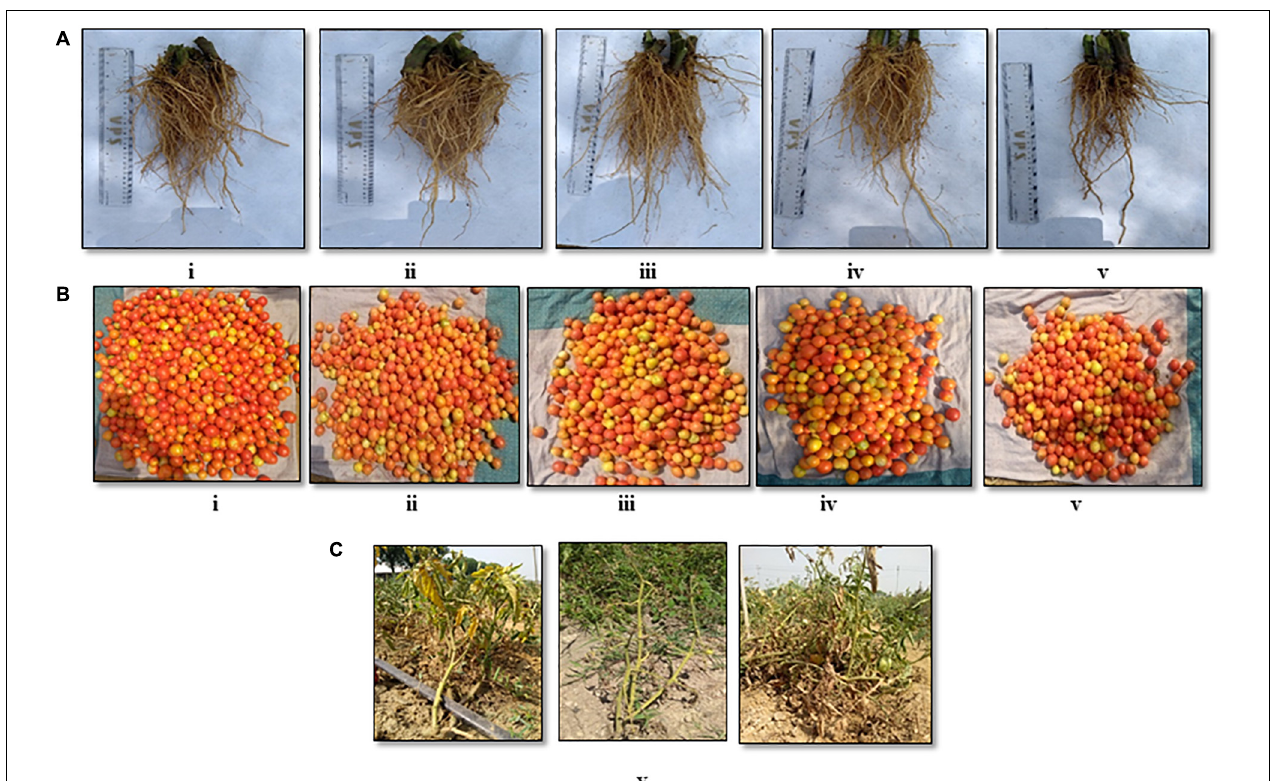
FIGURE 9 | Field evaluation [CPCT, I ARI] of the biocontrol agents to control Fusarium wilt of tomato (cv. Pusa Rohini) during harvest for (A) root growth, (B) fruit yield, (C) vascular wilt (i) S2BC-1 + TEPF-Sungal-1 + S17TH; (ii) S2BC-1 + S17TH + CG-A; (iii) TEPF-Sungal-1 + CG-A + S17TH; (iv) fungicide control (copper oxychloride- 0.25% + carbendazim-0.1%); (v) untreated